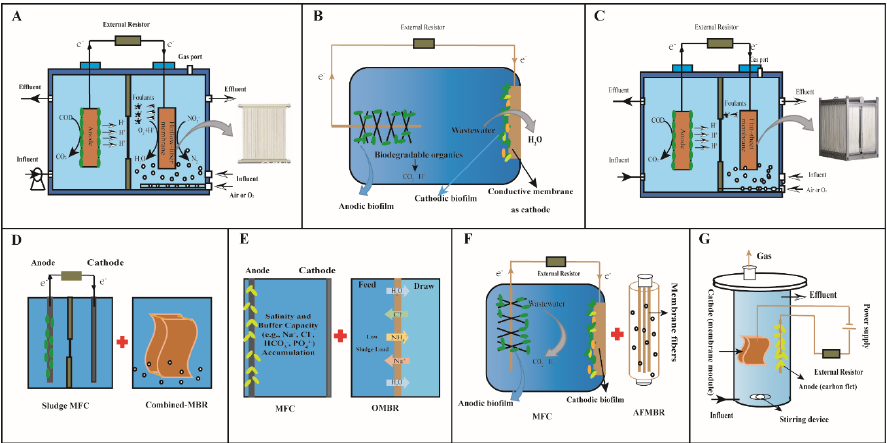
Figure 1. Schematic diagram of the MFC / MEC-MBR system. ( A ) Hollow-fiber membrane bioreactor and microbial fuel cell; ( B ) membrane bioreactor and air-bio cathode microbial fuel cell; ( C ) flat-sheet membrane bioreactor and microbial fuel cell; ( D ) membrane bioreactor and sludge microbial fuel cell; ( E ) osmotic membrane bioreactor and microbial fuel cell; ( F ) anaerobic fluidized bed membrane bioreactor and microbial fuel cell; ( G ) microbial electrolysis cell-anaerobic membrane bioreactor.